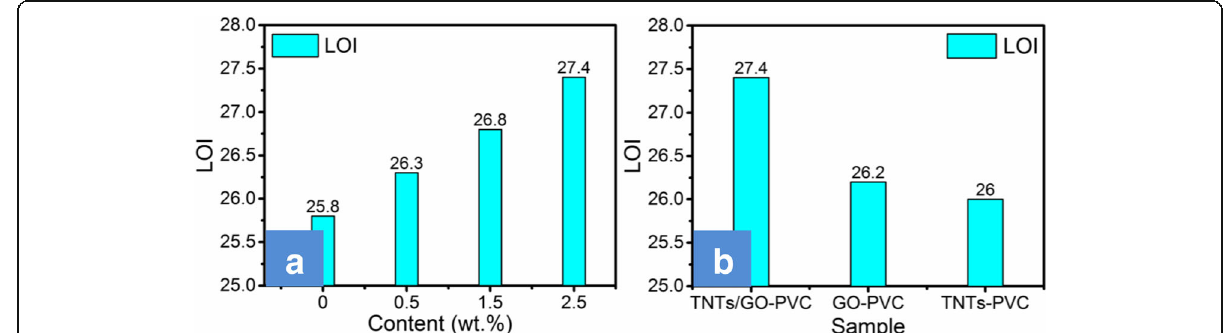
Fig. 6 LOI values of flexible PVC and PVC-matrix composites with various content of TNTs/GO ( a ) and with 2.5 wt.% of GO or of TNTs and TNTs/ GO ( b ). The PVC-matrix nanocomposites containing 2.5% of TNTs/GO nano-filler exhibits a maximum LOI of 27.4, higher than that of PVC filled with GO alone or TNTs alone. This demonstrates that there is the synergistic flame-retardant effect between TNTs and